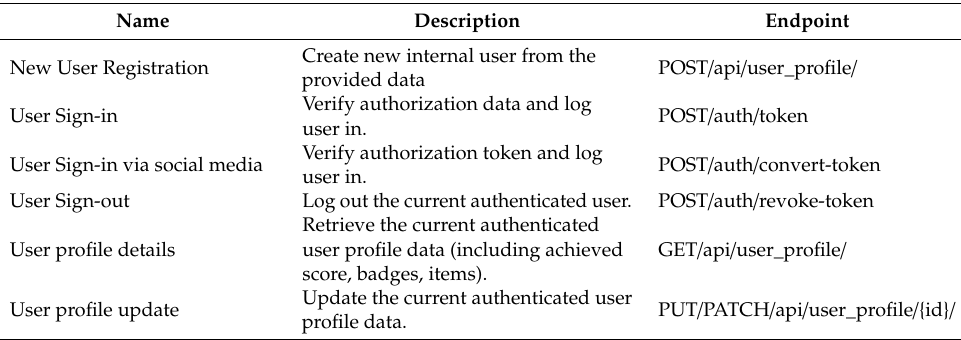
Table 1. Visitor account endpoints.